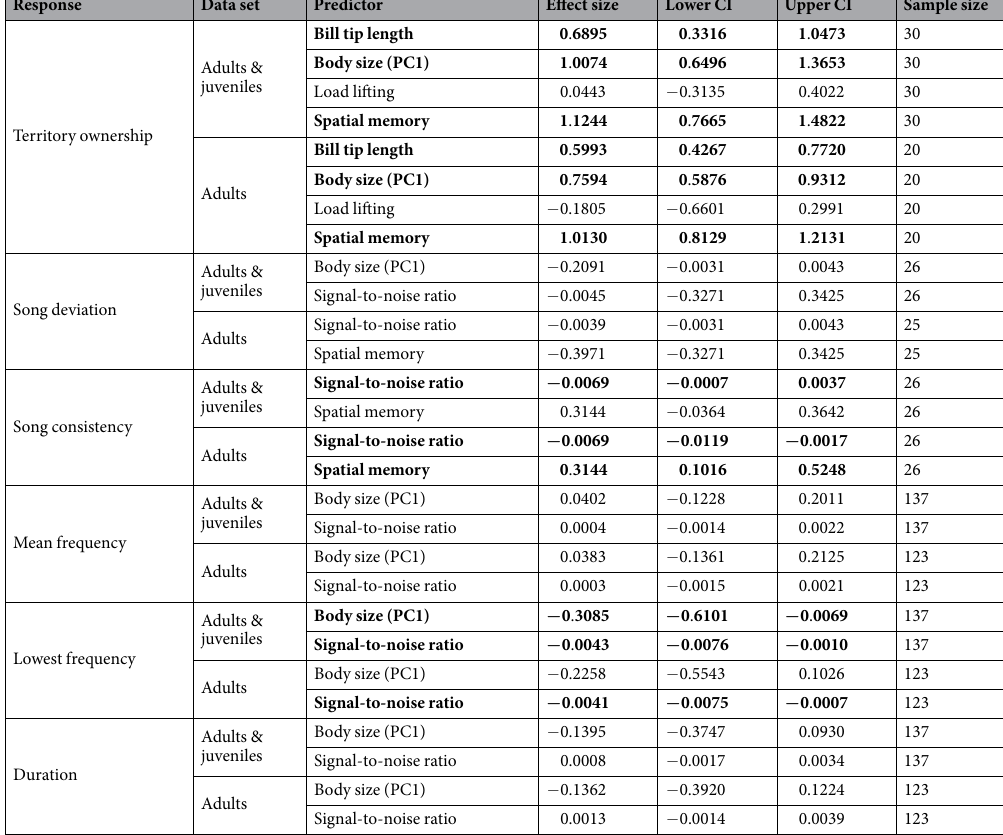
Table 1. Effect sizes and 95% confidence intervals for parameters predicting lek territory ownership and song structure in long-billed hermits. Effect sizes that did not overlap with zero are shown in bold.